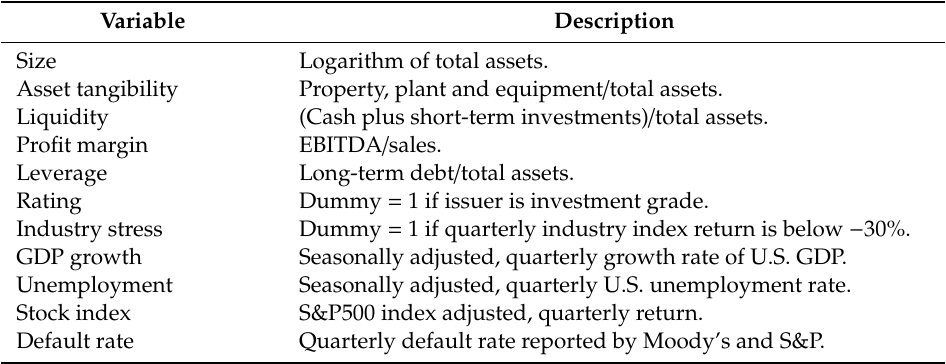
Table 3. Definition of explanatory variables.